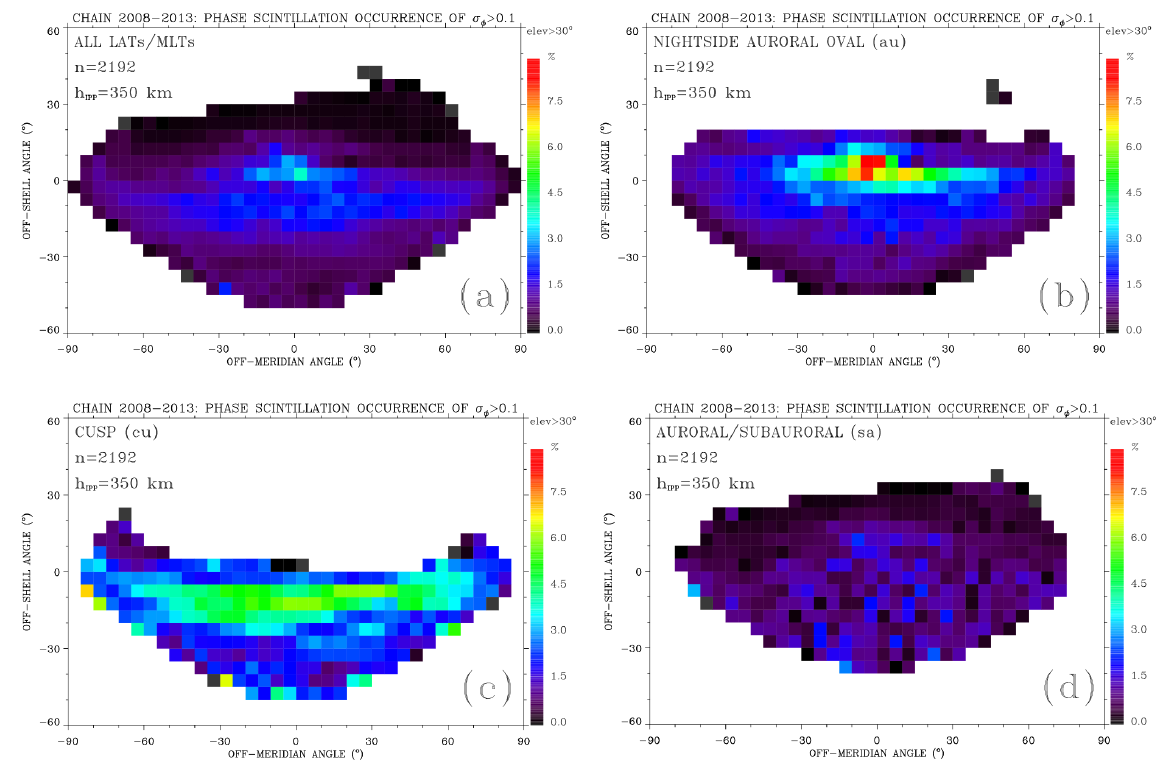
Figure 10. Maps of phase scintillation occurrence as a function of off-meridian and off-shell angles assuming h IPP = 350km for (a) all latitudes and MLTs combined, (b) au, (c) cu and (d)